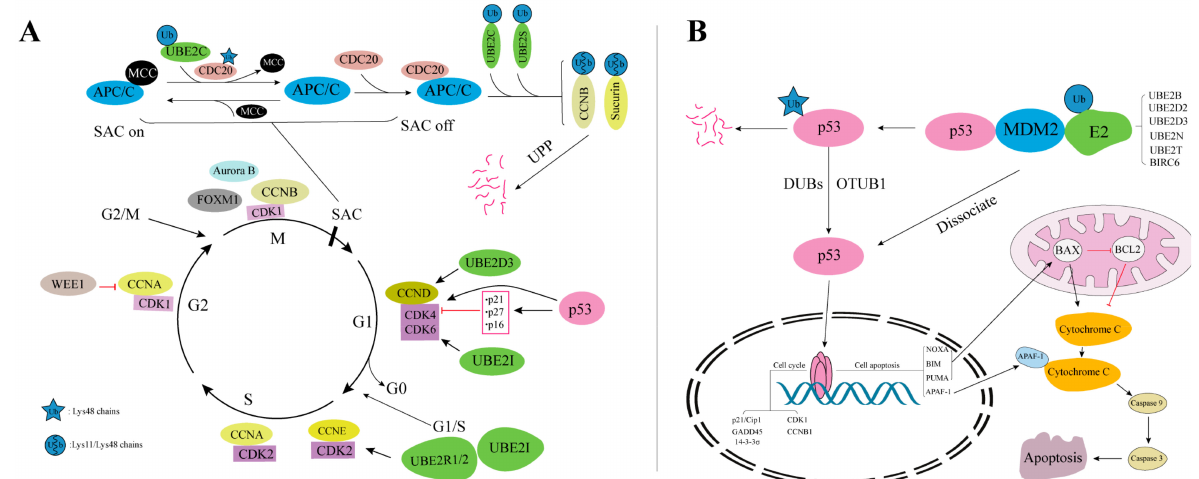
Figure 4. ( A ) E2s participate in the cell cycle process. ( B ) E2s regulate the cell cycle and apoptosis process by ubiquitinating p53. p53 upregulated modulator of apoptosis (PUMA) and BCL2-associated X (BAX) can induce apoptosis through increasing mitochondrial outer membrane